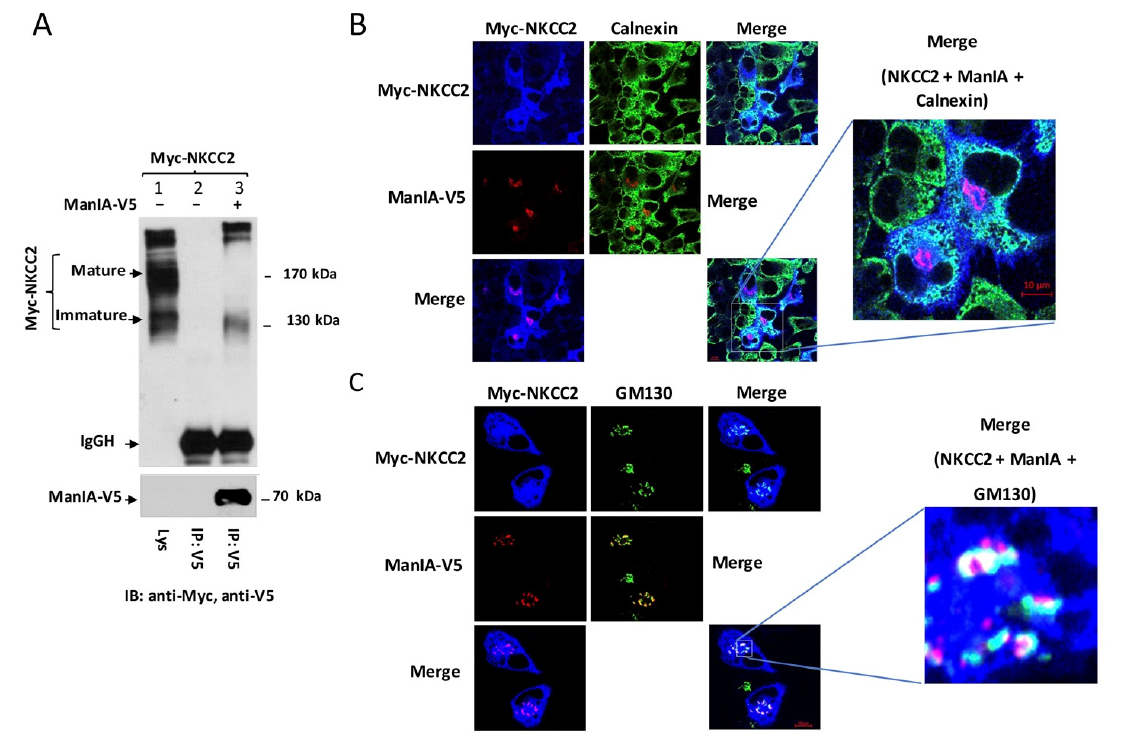
Figure 4. ManIA interacts with immature NKCC2 at the cis-Golgi in OKP cells, a second renal cell line. ( A ) ManIA interacts with immature NKCC2 in OKP cells. Cells were transiently transfected with Myc-NKCC2 either singly or in combination with ManIA-V5 construct. Cell lysates were immunopre- cipitated (IP) with anti-V5 antibody. NKCC2 protein was recovered from anti-V5 immunoprecipitates mainly in its immature form (lane 3). ( B , C ) Comparison of the cellular localization of Myc-NKCC2 and ManIA-V5 with the ER marker calnexin or the cis-Golgi marker GM130. Fixed and permeabilized cells were stained with mouse anti-Myc, rat anti-V5 and rabbit anti-calnexin ( B ) or anti-GM130 ( C ) antibodies. The merge color indicates overlap between the Myc tag of NKCC2 protein (Alexa Fluor 647, Blue), the V5 tag of ManIA (Alexa Fluor 555 goat anti-rat, red) and the ER marker calnexin (FITC, green) or the cis-Golgi marker GM130 (FITC, green) and representing colocalization of the proteins. Bars, 5 µ